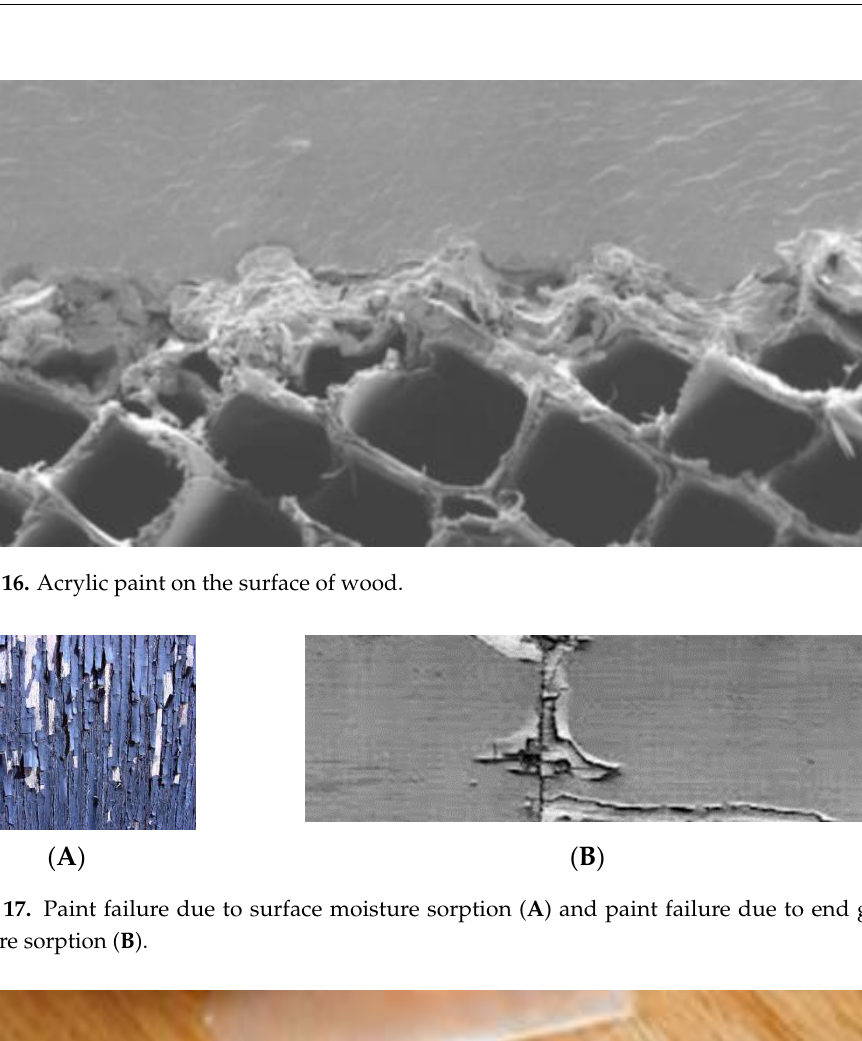
Figure 18. Clear coating failure.